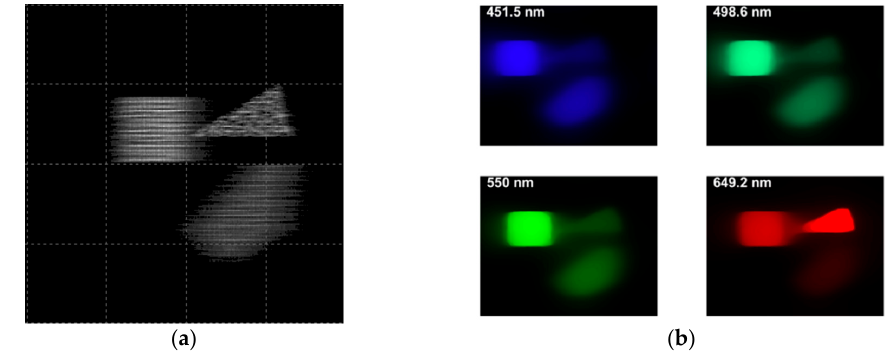
Figure 12. Sample results of the DP-CASSI system at an air gap of 4.24 mm: ( a ) spatial–spectral multiplexed raw grey scale image of the three targets ( b ) color images of the scene in CIE 1964 color scheme at four different wavelengths reconstructed through the linear inverse equation (Equation (6)) using regularizer τ = 0.5.